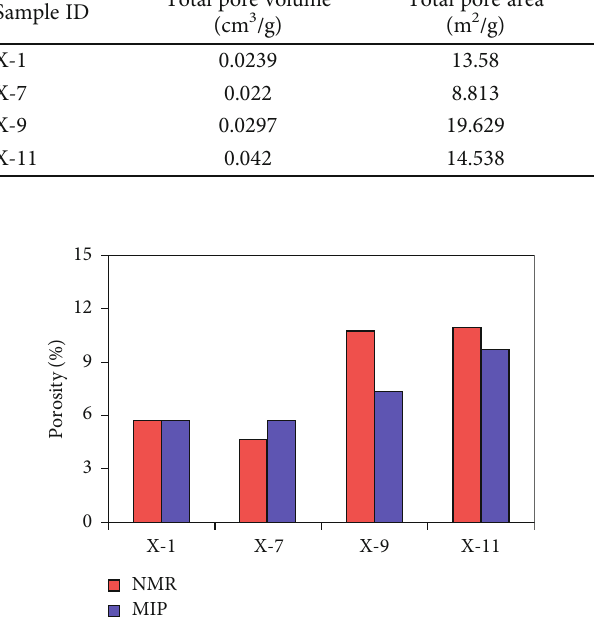
Figure 11: Porosity results from MIP and NMR tests for four